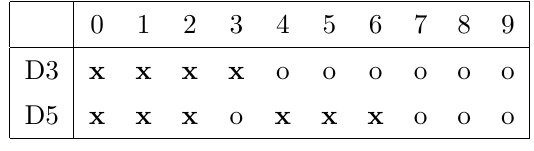
Table 1. Brane setups realizing the (cid:12)eld theory as well as its holographic dual. In a) N color D3 branes intersect n f (cid:13)avor D5 and anti-D5 branes. in b) the same n f (cid:13)avor D5 branes intersect k Hall D7